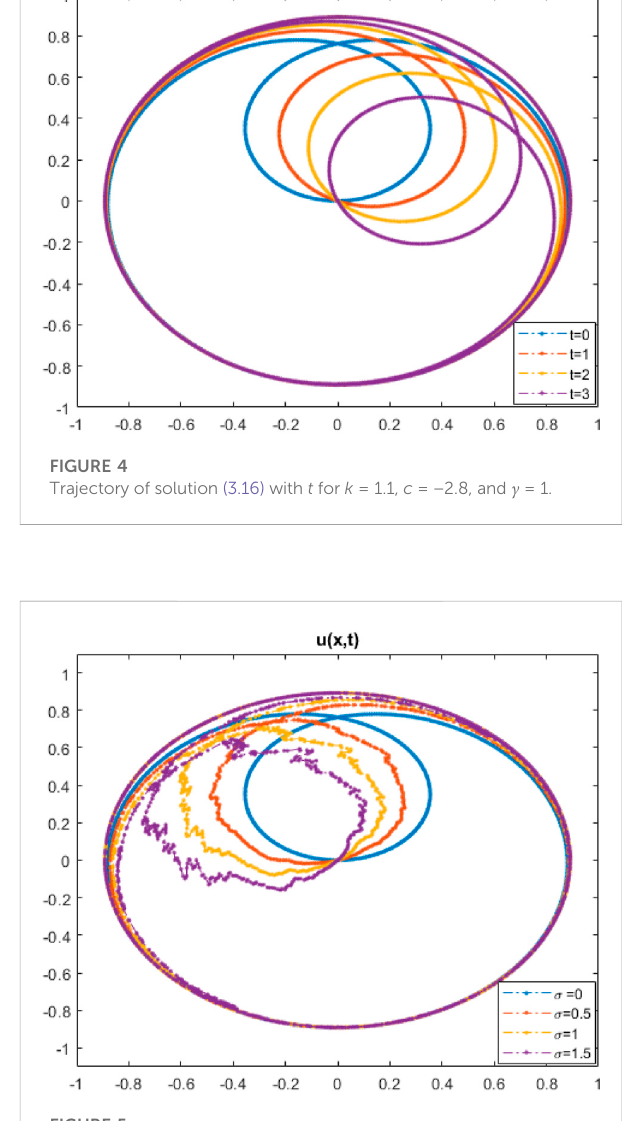
FIGURE 5 Trajectory of solution (3.16) with σ for k = 1.1, c = − 2.8, and γ =